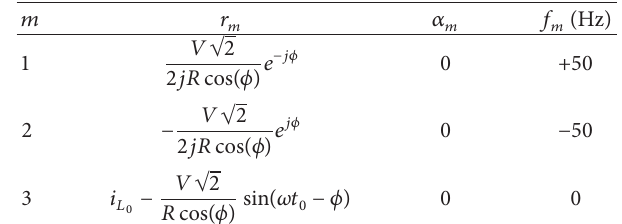
Table 3: The residues, attenuation factors, and frequencies of the parallel RL load.